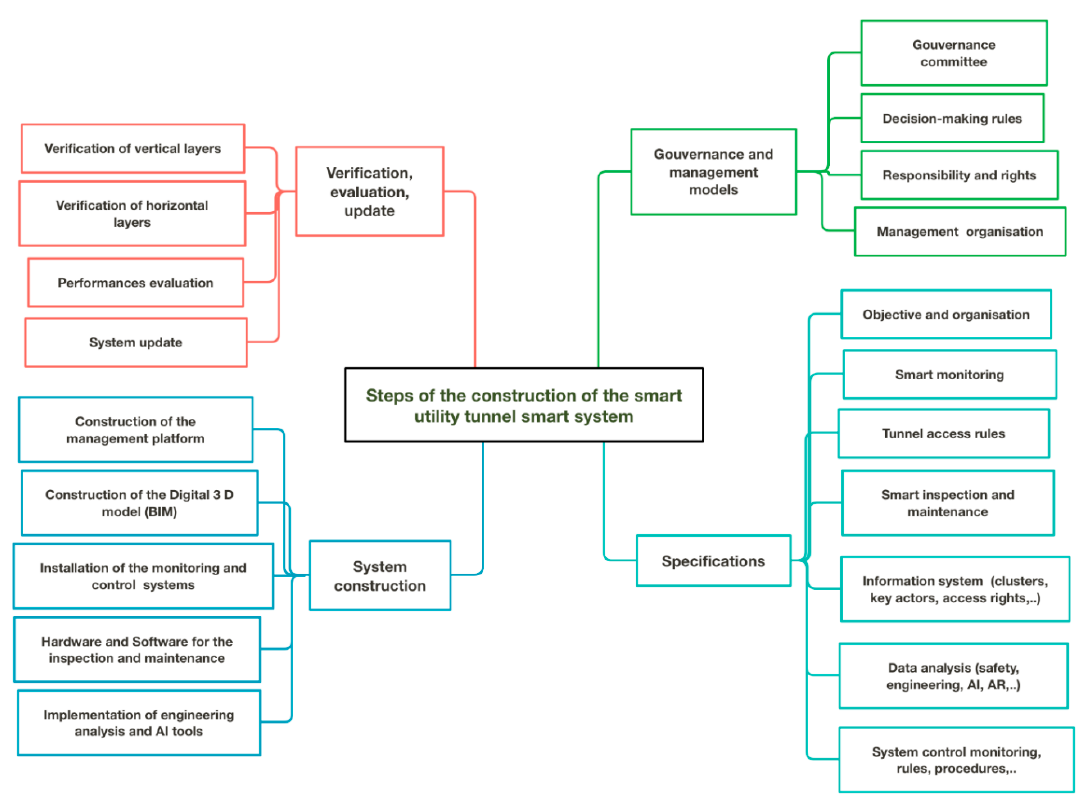
Figure 9. Construction of the utility tunnel smart system.